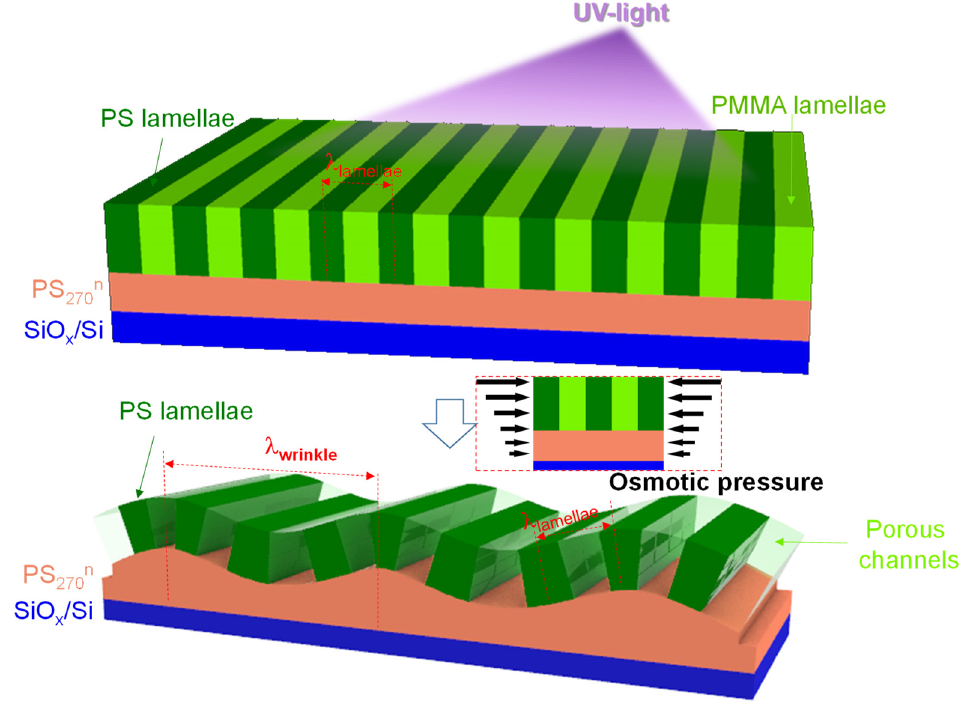
Figure 7. Schema of surface wrinkling of perpendicular lamellae in thin films of neat P(S-b-MMA) and its blends with a low content of PS during UV-light exposure followed by acetic acid rinsing. The parallel arrows shown in the middle diagrammatic sketch denote the magnitude gradient of osmotic pressure.